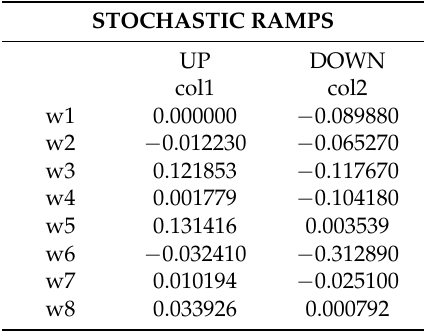
Table A24. Stochastic ramp-up and ramp-down rates of wind production: w_stoch_max_1( t , w ,robust).